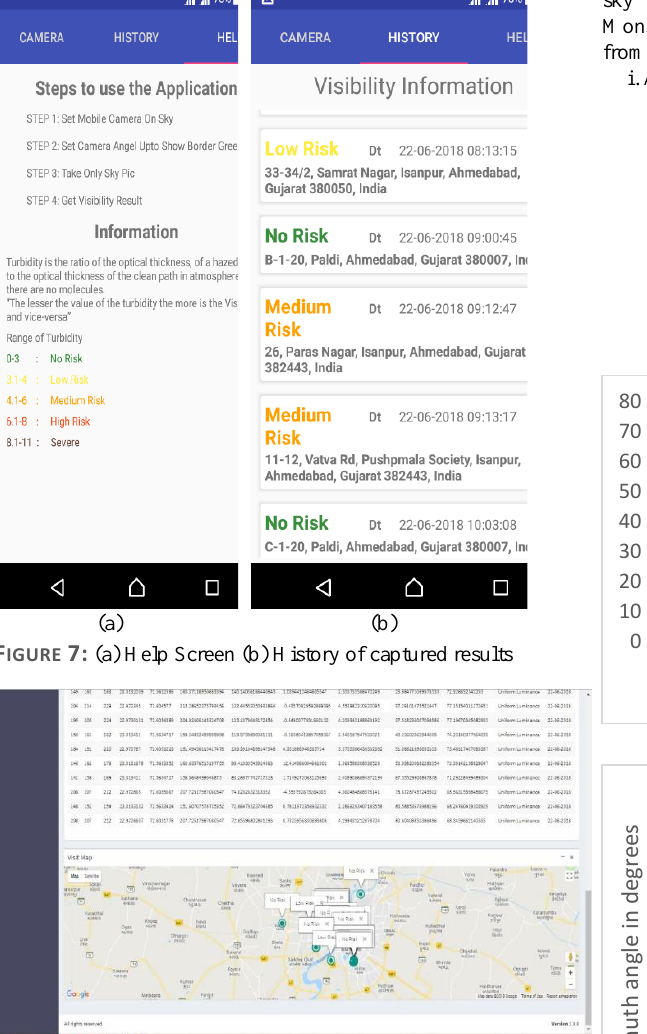
Figure 8: Turbidity mapping on Google maps